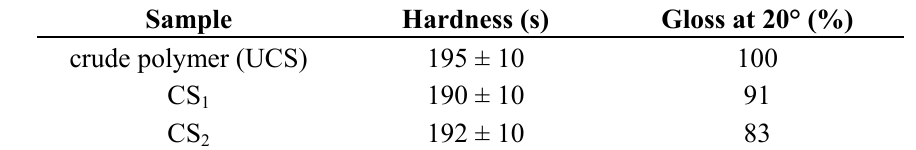
and CS nanocomposites depending on the filler 1 2